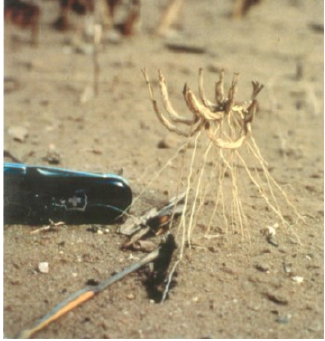
Figure 1. About 50 mm of soil blown from cropland in Kansas during the winter